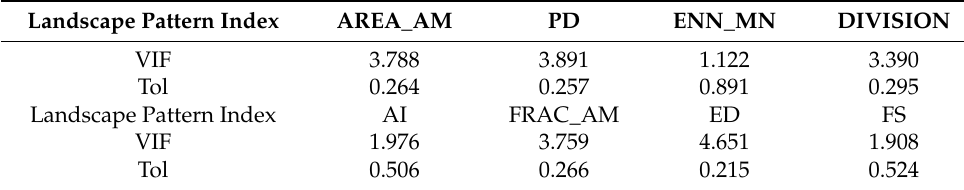
Table 2. Test results of multicollinearity among landscape pattern